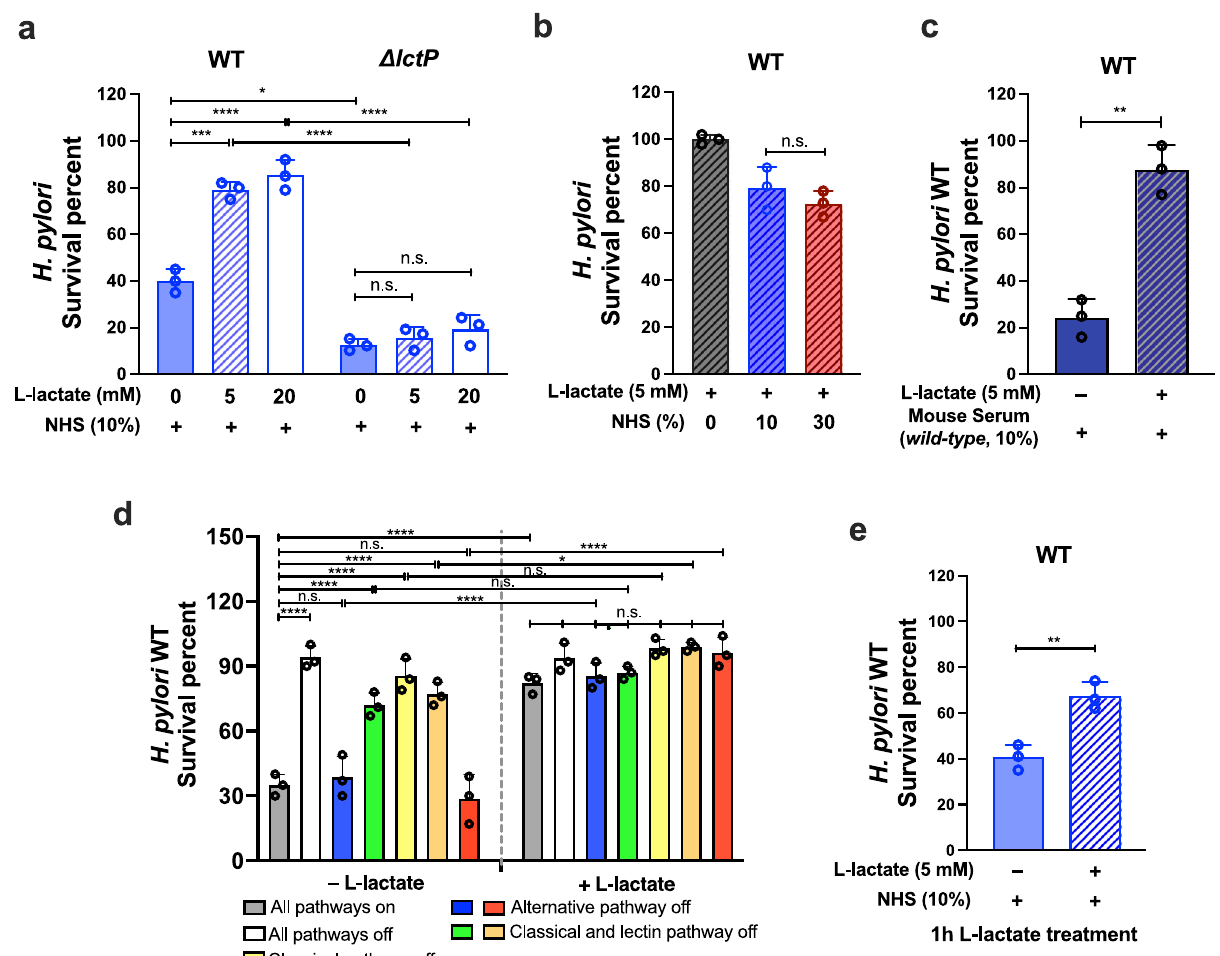
Fig. 3 | L-lactate protects H. pylori from complement-mediated elimination. Overnight culturesof H.pylori PMSS1 WTor Δ lctP mutant with orwithout L-lactate supplementation overnight or for 1h, as indicated, were treated by inactive and activeserumfor1h,andthenviablebacterialCFUsweredeterminedbyplating.The survival percent was determined as described in Fig. 2. a Overnight cultures of H. pylori WTor Δ lctP mutantgrownwiththeindicatedconcentrationofL-lactatewere treated by inactive and active 10% NHS. b Overnight cultures of WT H. pylori with 5mM L-lactate supplementationwastreatedbyindicatedpercentageofNHS. c WT H. pylori cultures were treated with C57BL/6J mouse serum. d H. pylori cultures were treated by NHS only (gray bar), EGTA-conditioned NHS (white bar), C1q- depleted human serum (yellow bar), C2-depleted human serum (orange bar),